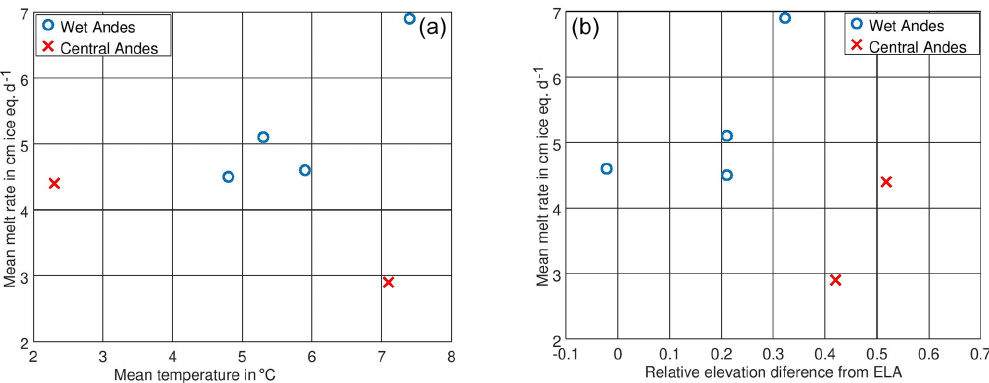
Figure 11. Melt rate in the different zones as a function of temperature (a) and as a function of the relative elevation difference from the ELA (b)